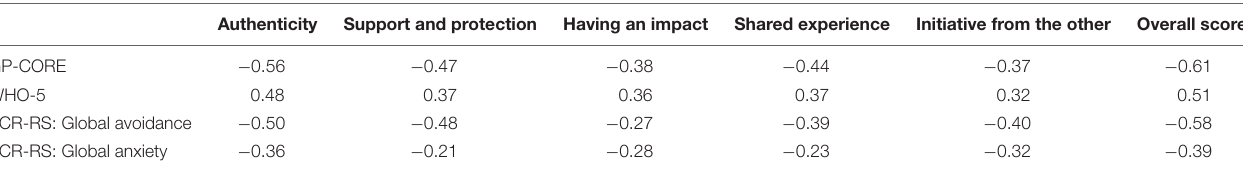
TABLE 5 | Convergent validity of